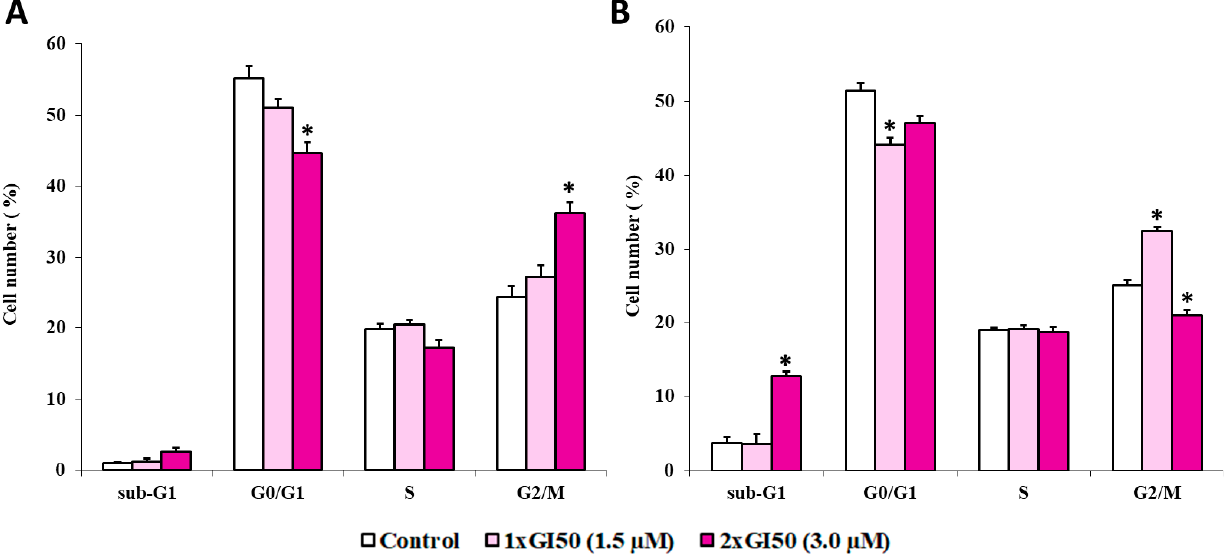
Figure 9. The effects of J3955 at 2 × and 1 × its GI 50 value on the cell-cycle distribution of HepG2 cells following 12 h ( A ) and 24 h ( B ) treatments. Results are expressed as the mean of two independent experiments, performed in duplicate. Statistical analyses were performed using the Student’s t -test to determine the differences between the datasets. * Denotes significant differences ( p < 0.0001) from untreated cells (control).